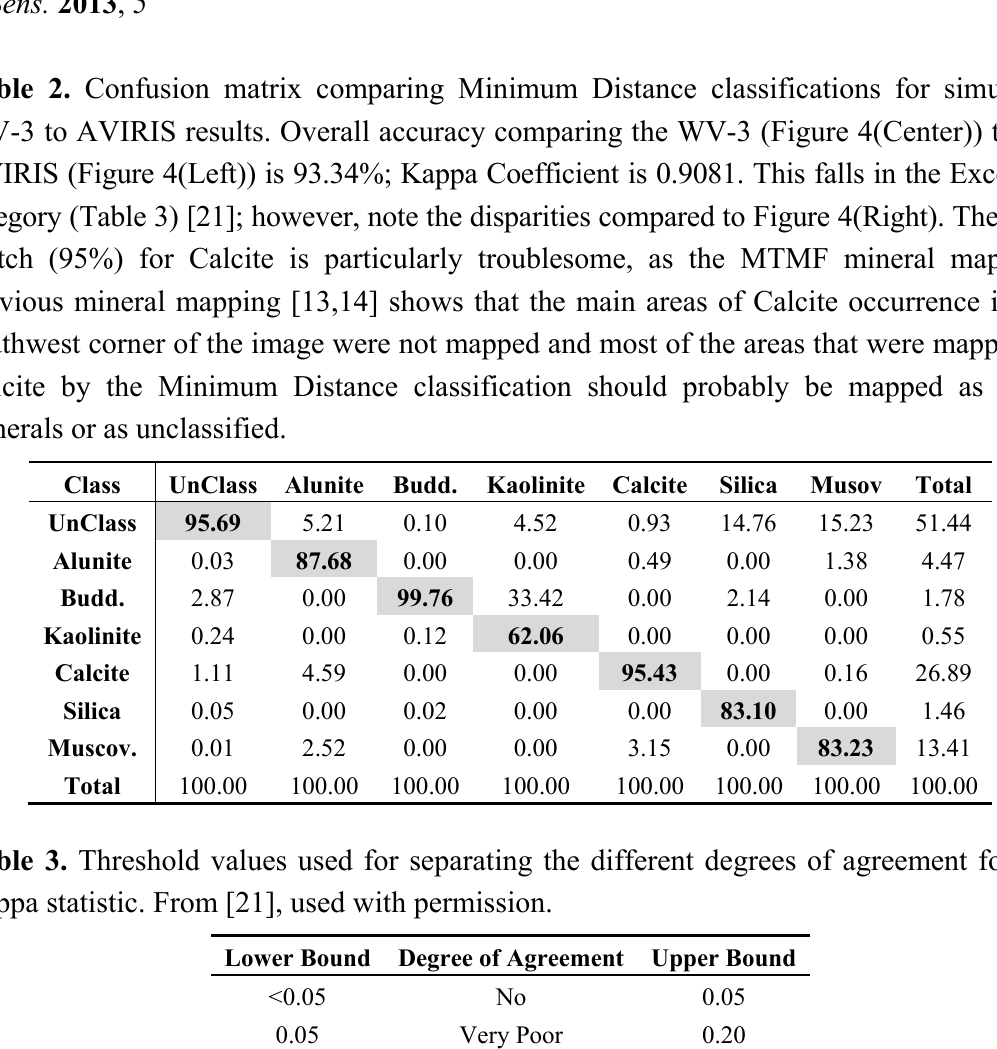
Table 2. Confusion matrix comparing Minimum Distance classifications for simulated WV-3 to AVIRIS results. Overall accuracy comparing the WV-3 (Figure 4(Center)) to the AVIRIS (Figure 4(Left)) is 93.34%; Kappa Coefficient is 0.9081. This falls in the Excellent